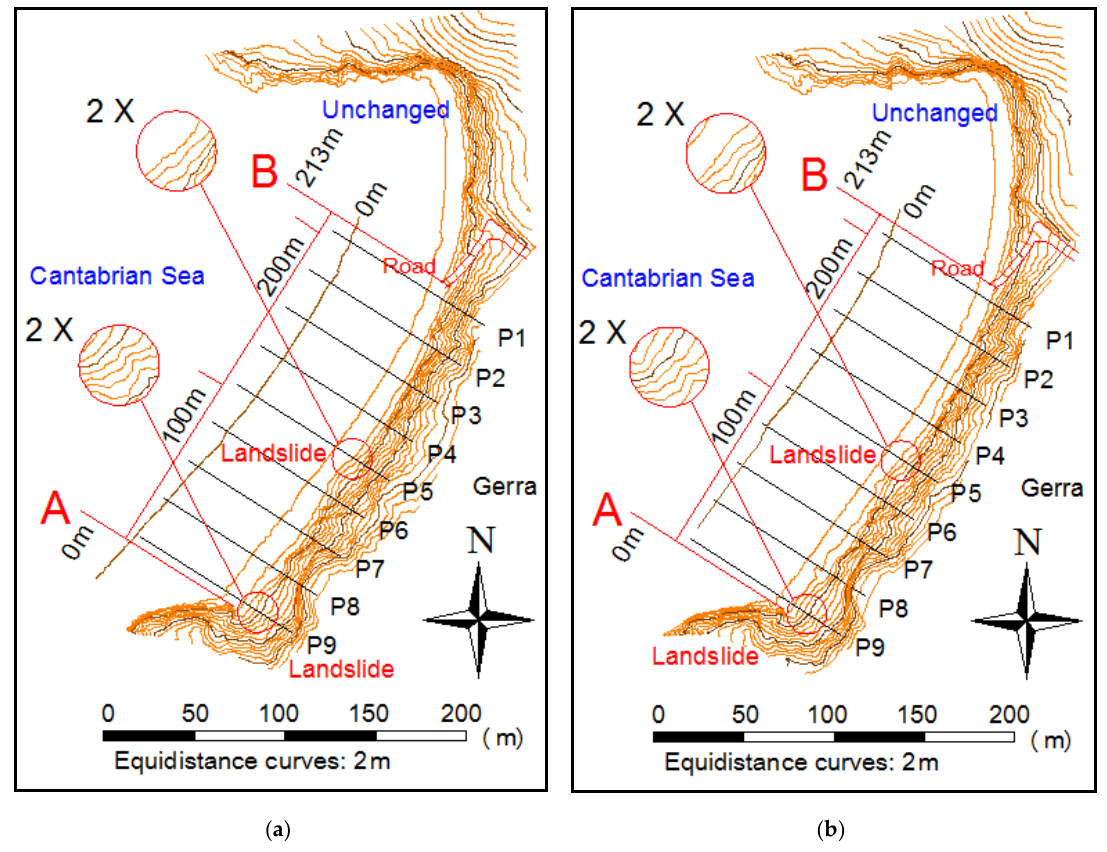
Figure 4. Indication of the most significant landslide zones (red circles) according to terrestrial laser scanner (TLS) surveys of Gerra beach. ( a ) Digital elevation model (DEM) of October 2018; ( b ) DEM of April 2019.